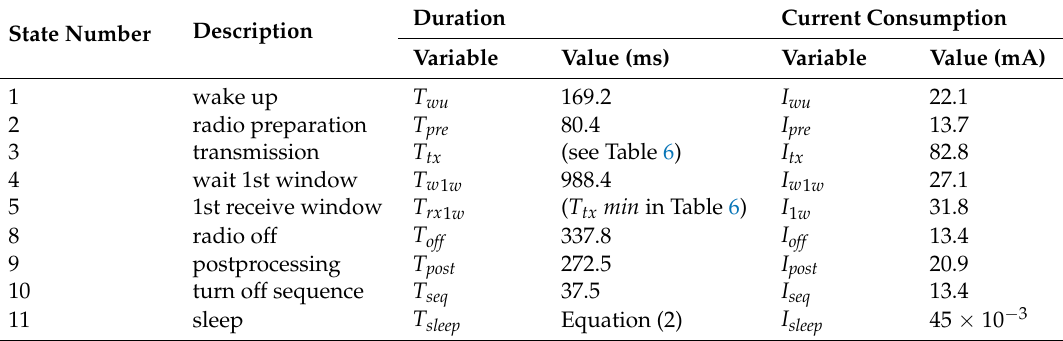
Table 7. States, variables and their values for LoRaWAN acknowledged transmission when the acknowledgment is sent in the first receive window.